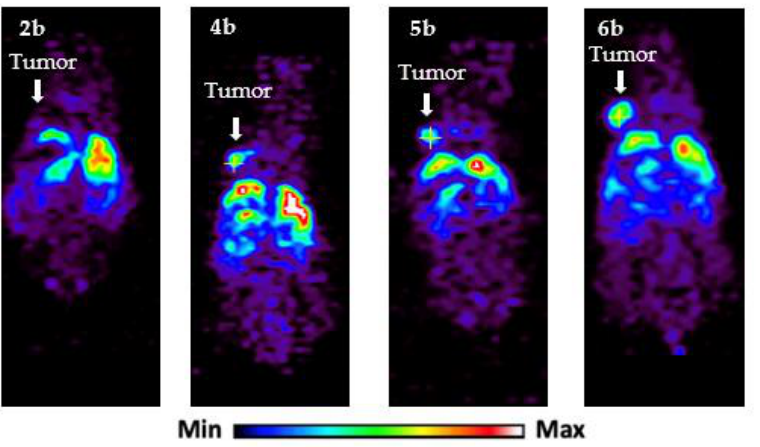
Figure 3. Representative whole-body coronal PET images of tumor-bearing mice at 45 hrs post-injection of PEG-MTX-AuNP conjugate 2 ( 2b ), MTX-RGD-AuNP conjugate 4 ( 4b ); Glu-RGD-AuNP conjugate 5 ( 5b ), Glu-MTX-AuNP conjugate 6 ( 6b ). Table 4. SUV Max of gold nanoparticle conjugates in tumor.